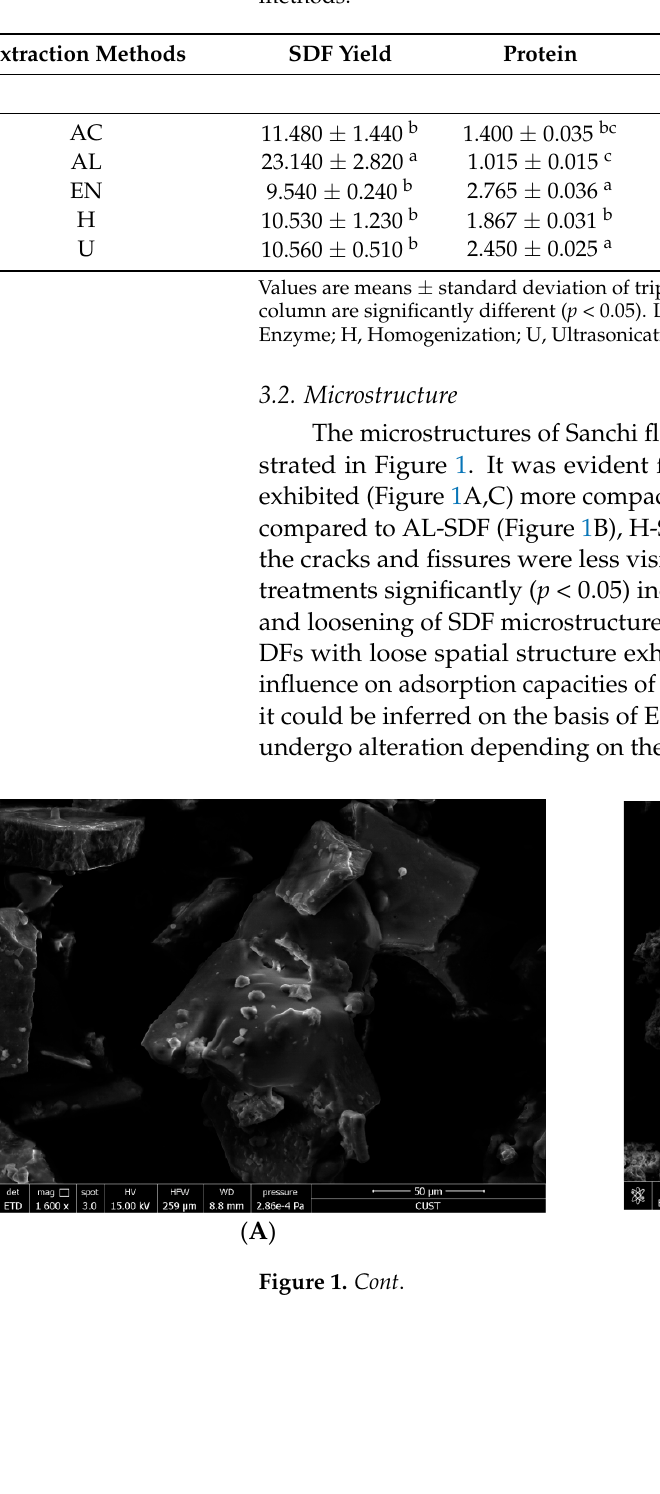
Table 1. SDF yield, protein and color values of Sanchi flower dietary fiber extracted by different methods.